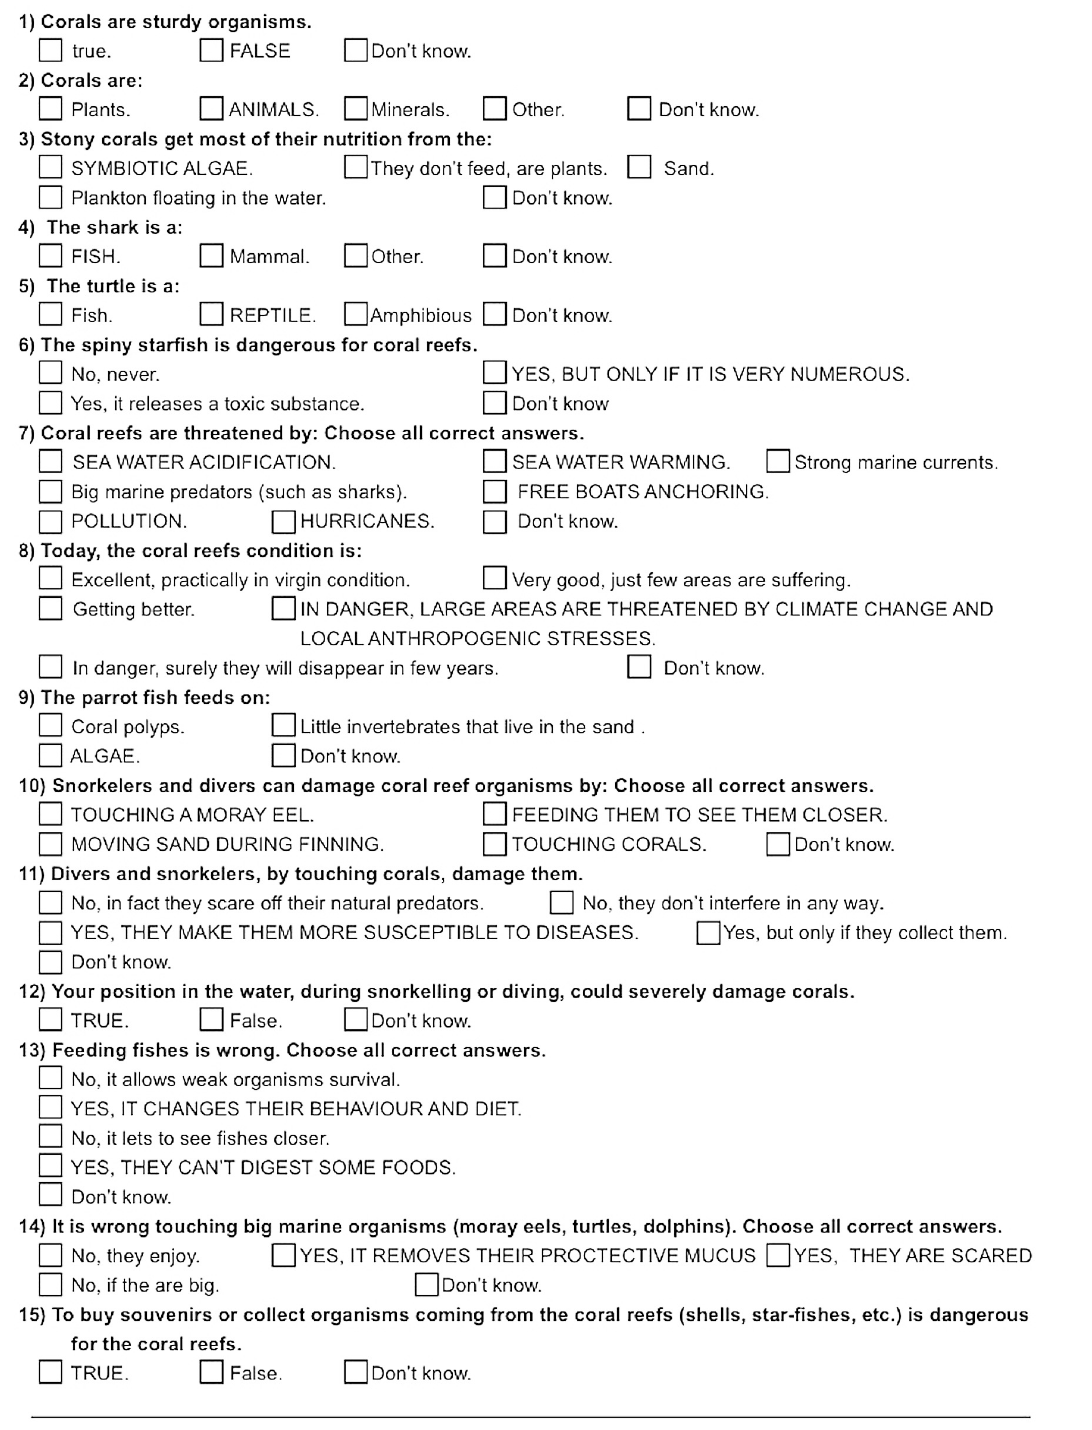
Fig 1. Environmental education evaluation questionnaire. The figure show the section dedicated to the evaluation of the level of environmental education. The answers in capital letters show the correct answer. STE project-Citixen Science Lab , Marine Science Group , Dipartimento di Biologia E . S